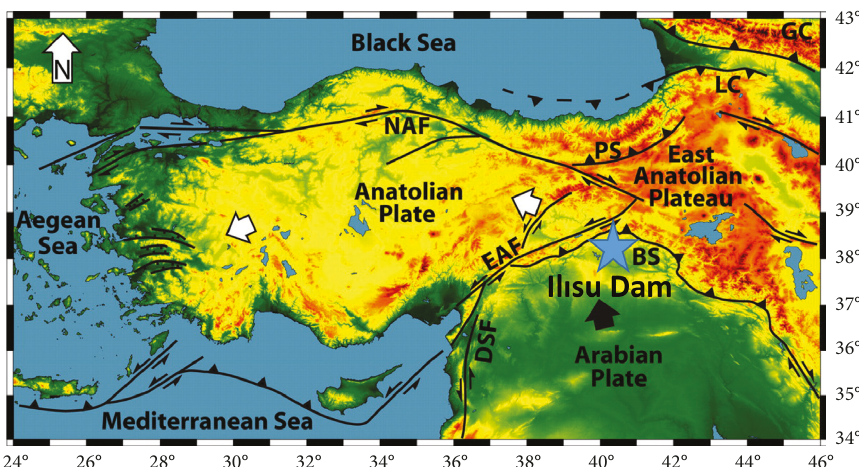
Figure 12: The fault map of Turkey and location of the Ilısu dam in seismic faults.